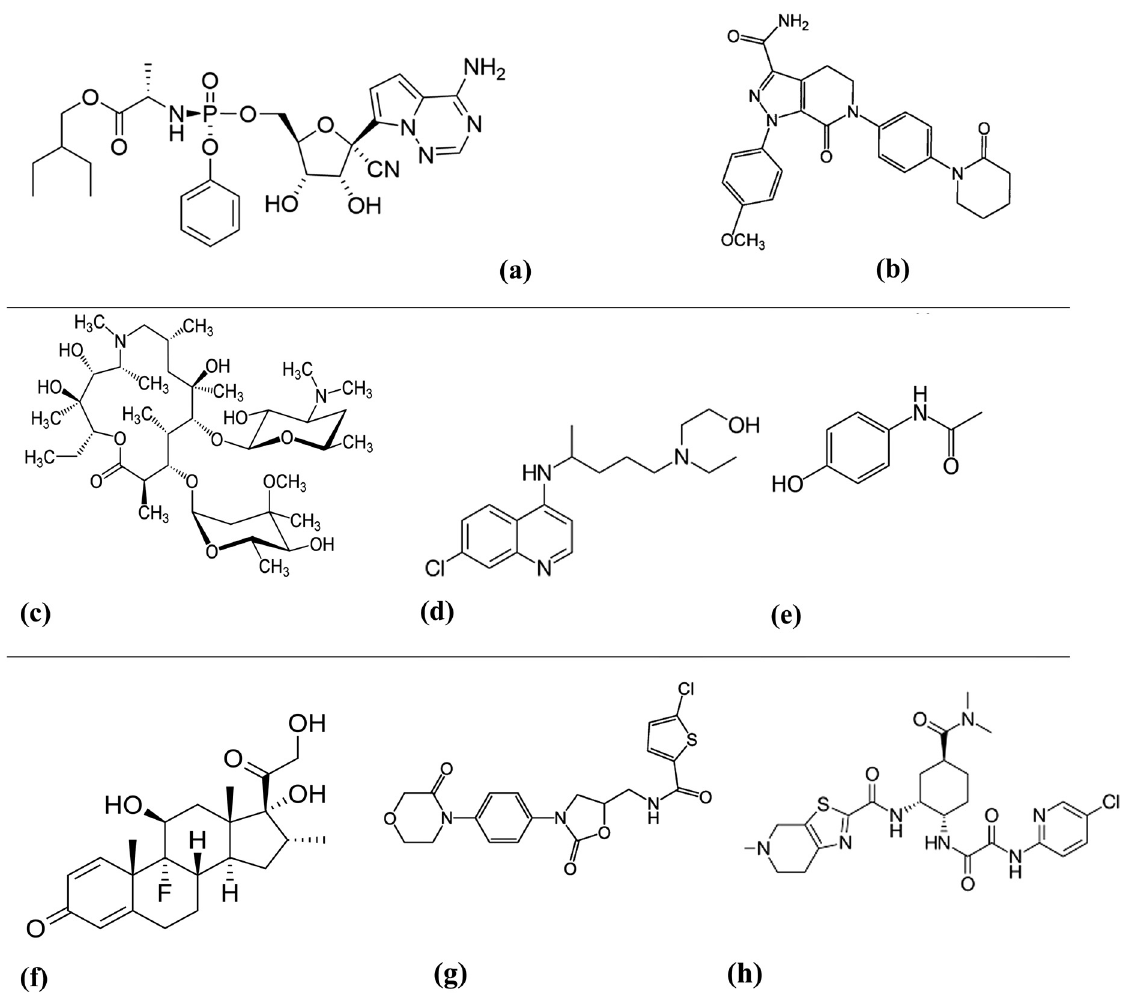
Figure 1: Chemical structures of ( a ) RM, ( b ) AX, ( c ) AZ, ( d ) HY, ( e ) PR, ( f ) DX, ( g ) RX, and ( h )